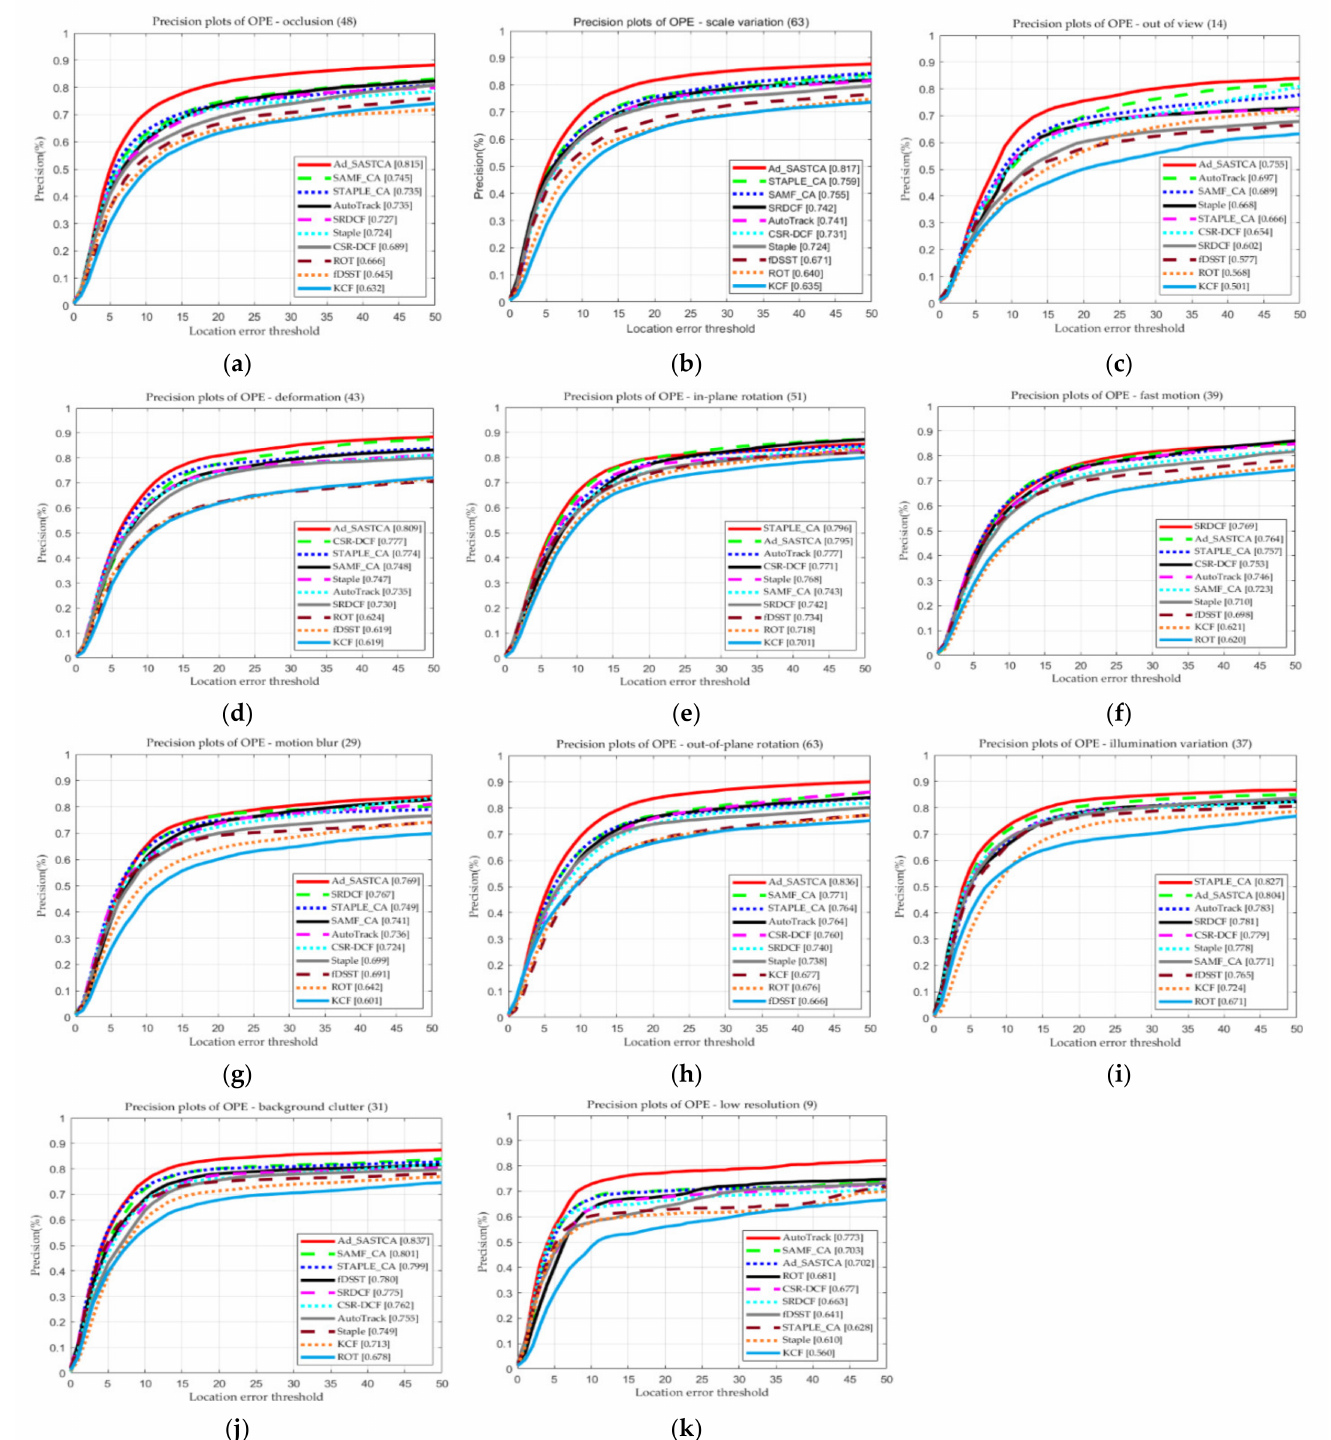
Figure 5. Attribute based evaluation. Precision plots ( a – k ) are indicated on the OTB-2015 dataset for 11 challenge attributes. Precision rates are reported in brackets. The title of each plot includes the number of videos related